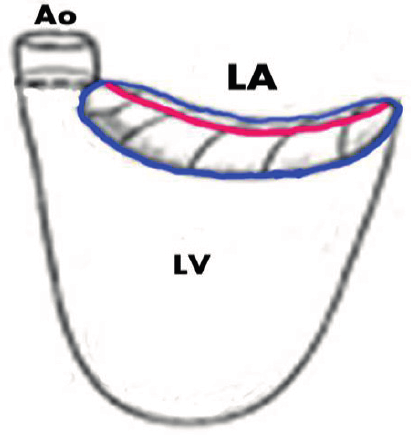
Figure 1. Scheme of the mitral valve anatomy with the saddle shaped annulus ( blue ) and the plane of the valve as seen in para-sternal long axis view on echo ( pale red ) showing the two high points of the annulus. Ao = aorta, LV = left ventricle, LA = left